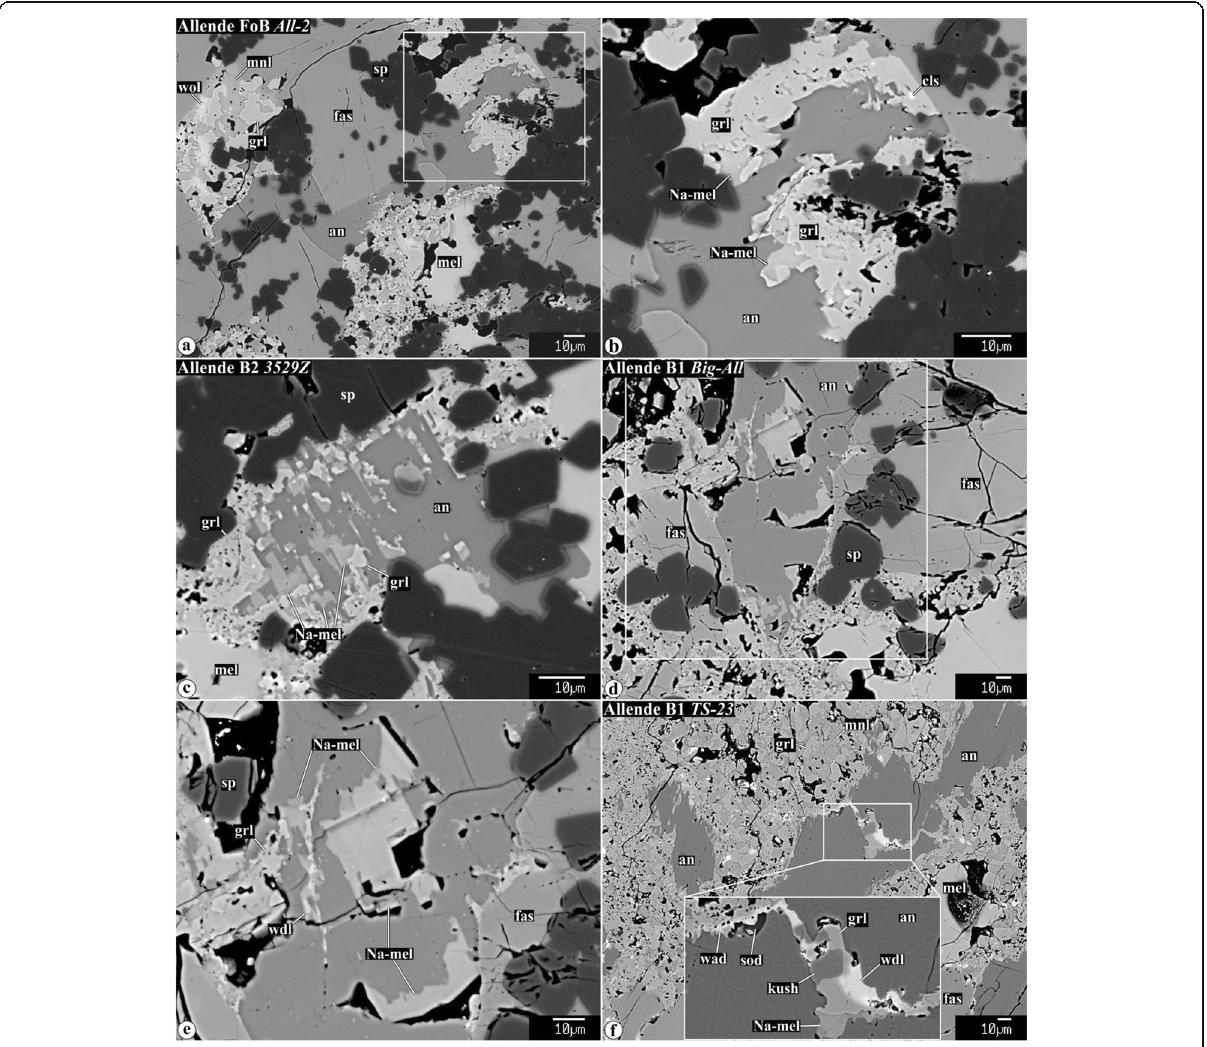
Fig. 7 Backscattered electron images of Alteration of primary igneous anorthite in the interior regions of the Type B1, B2, and FoB Allende CAIs. Regions outlined in a and e are shown in details in b and f . Anorthite along the boundaries with heavily altered regions of åkermanitic melilite contains irregularly shaped embayments, inclusions along cleavage planes, and veins of Na-melilite, grossular, kushiroite, and wadalite. Occasionally, wadalite is replaced by sodalite. Na-melilite growing into open space shows euhedral outlines (see e and f ). Variations in brightness of Na-melilite correspond to variations in Na 2 O